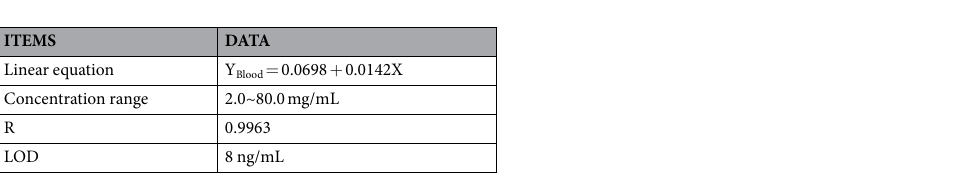
regression slopes, intercepts and correlation coefficients of the calibration curves from samples were presented correspondingly in Table 3. Repeatability, Precision and Recovery.